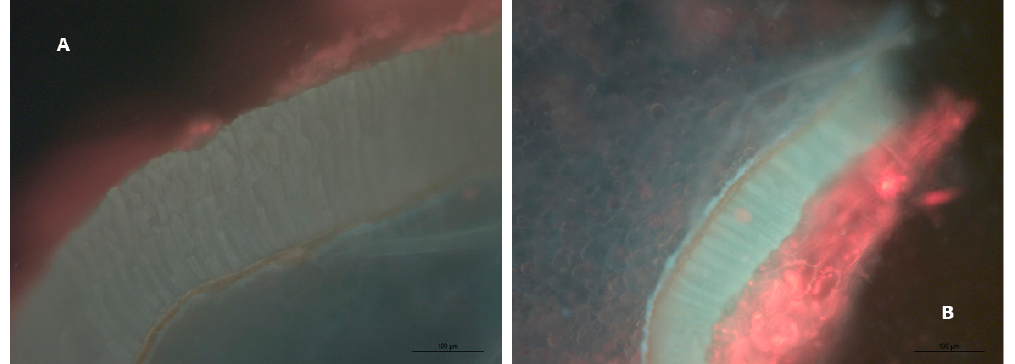
Figure 5. Epifluorescence microscopy of the exterior of grape skins at 400× magnification. Note the fluorescing bright dots in the 5–10 micron range, and the disappearance of fluorescing dots over time. ( A ) Day 0 of fermentation, ( B ) Day 14 of fermentation. ( A ) Day 0 of fermentation, ( B ) Day 14 of fermentation.